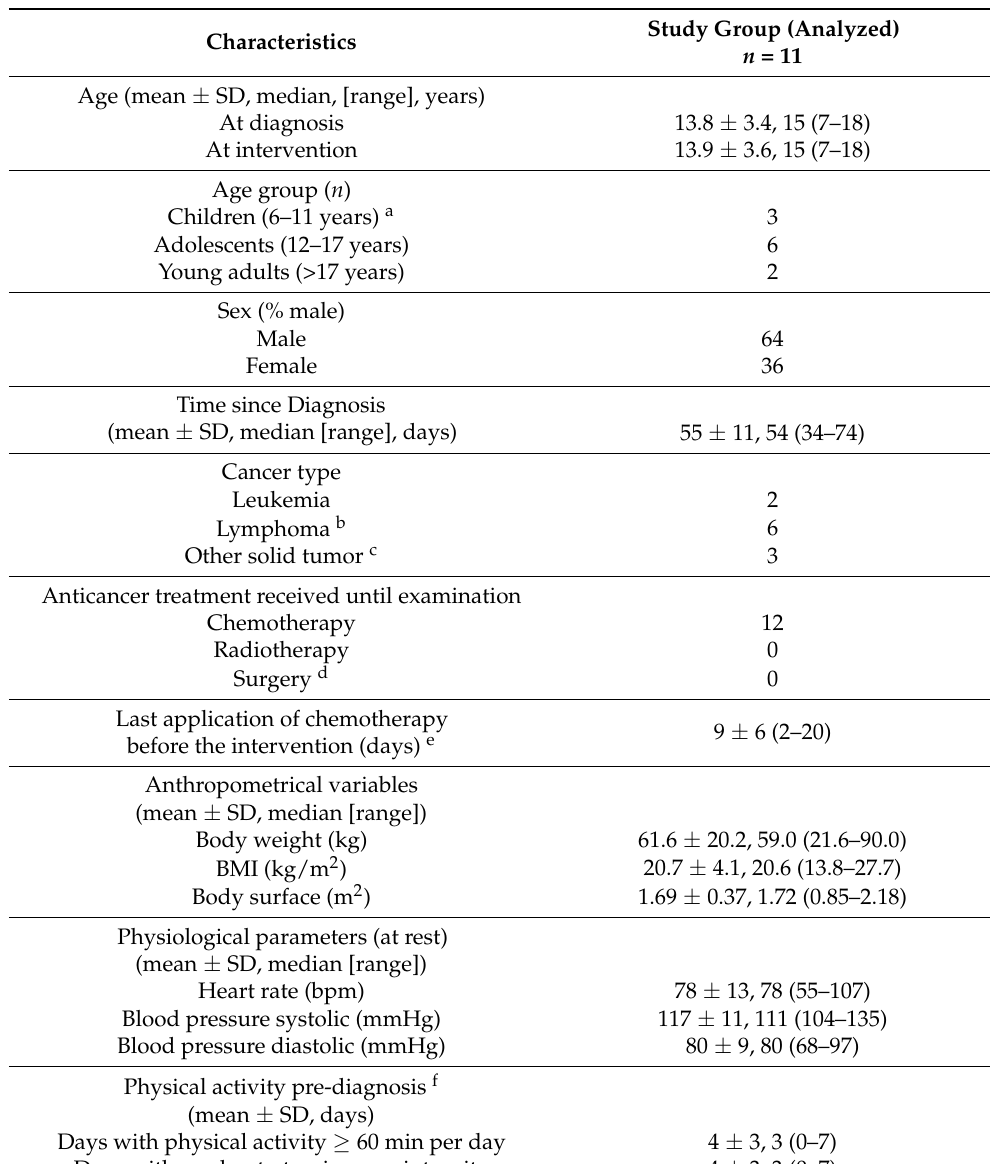
Table 1. Participant